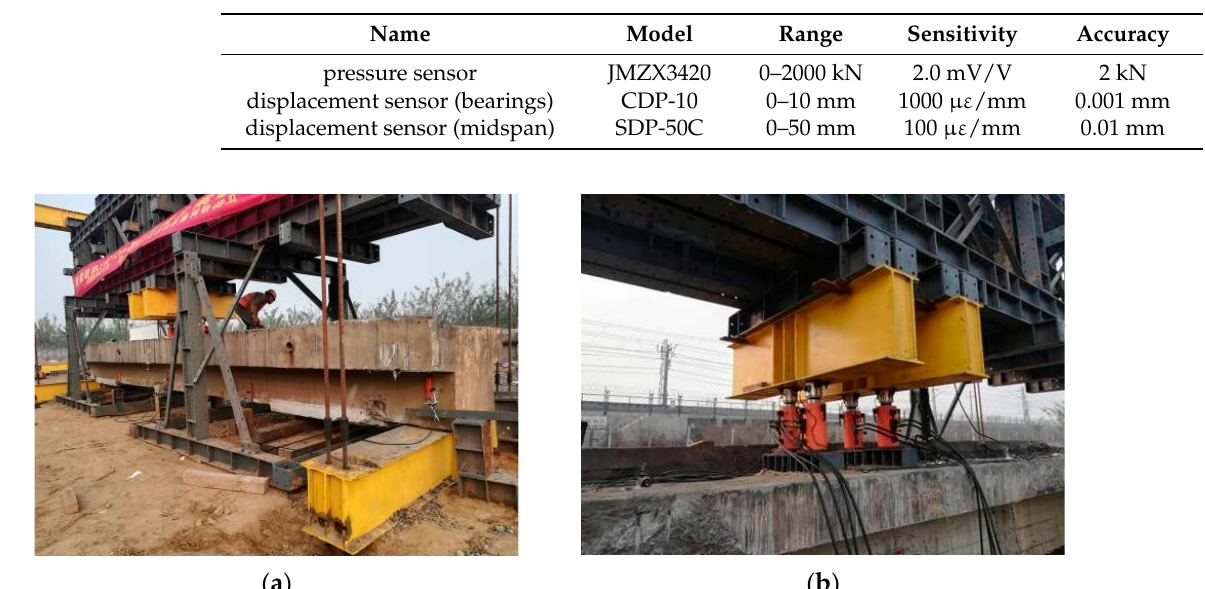
Figure 7. Field test. ( a ) Installation of the test beam; ( b ) loading with jacks.